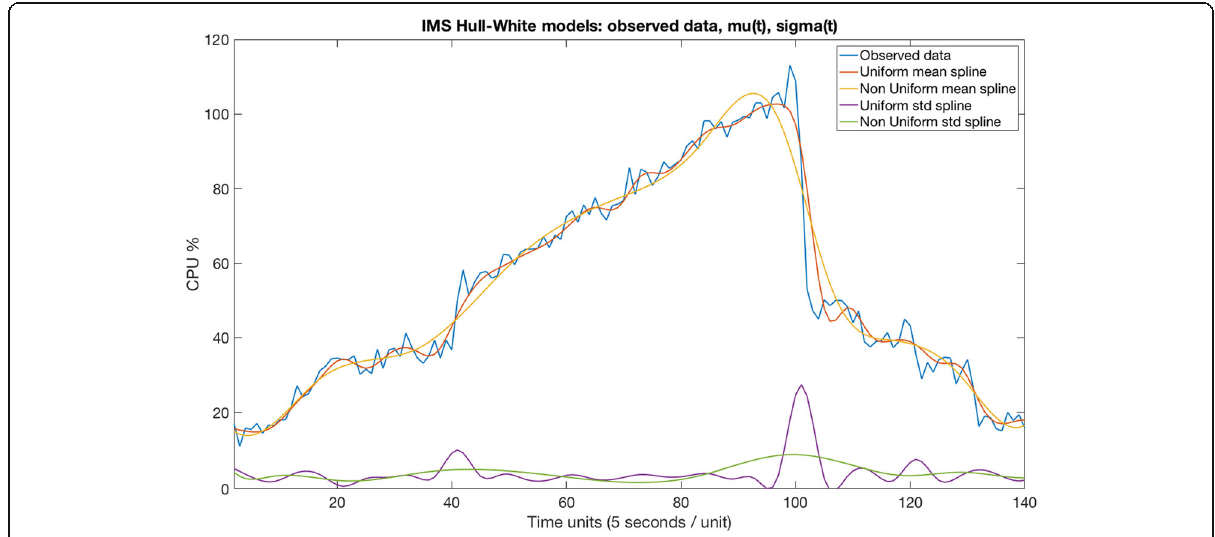
Fig. 2 IMS1 Hull-White sampled splines: Observed data, μ (t), σ